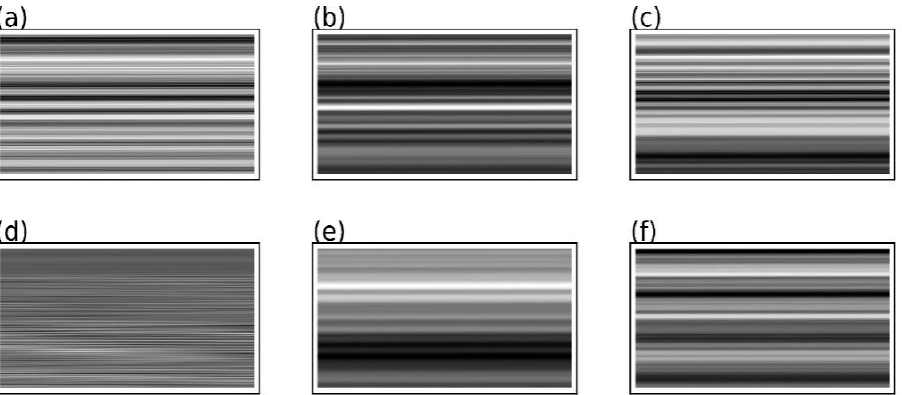
Figure 6. Grayscale image of six signals: ( a ) climbing, ( b ) shearing, ( c ) wind blowing, ( d ) sawing, ( e ) pushing and pulling, and ( f )